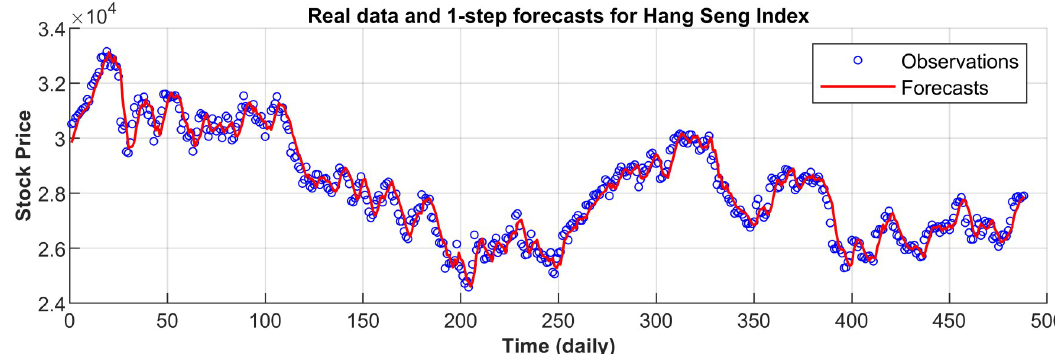
Fig 3. 1-step forecasts of the nPRM and market values for Hong Kong Hang Seng Index.